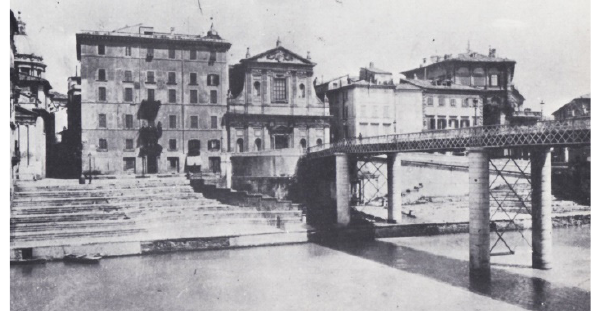
Figure 6. Ripetta Bridge and the old harbour (Cottrau, 1878)